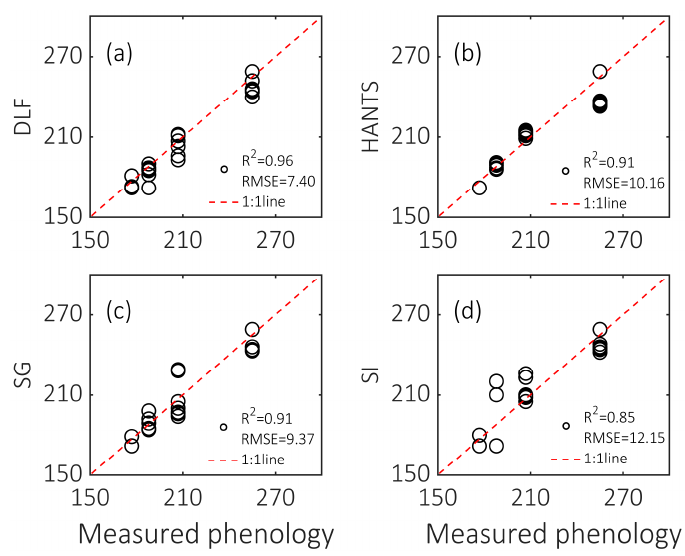
Figure A1. Comparison of extracted and observed phenology from ground observations of maize using different filtering methods at the site in Shangqiu in 2018. Note: ( a – d ) represented the comparison of extracted phenology using DLF, HANTS, SG, and SI, respectively.